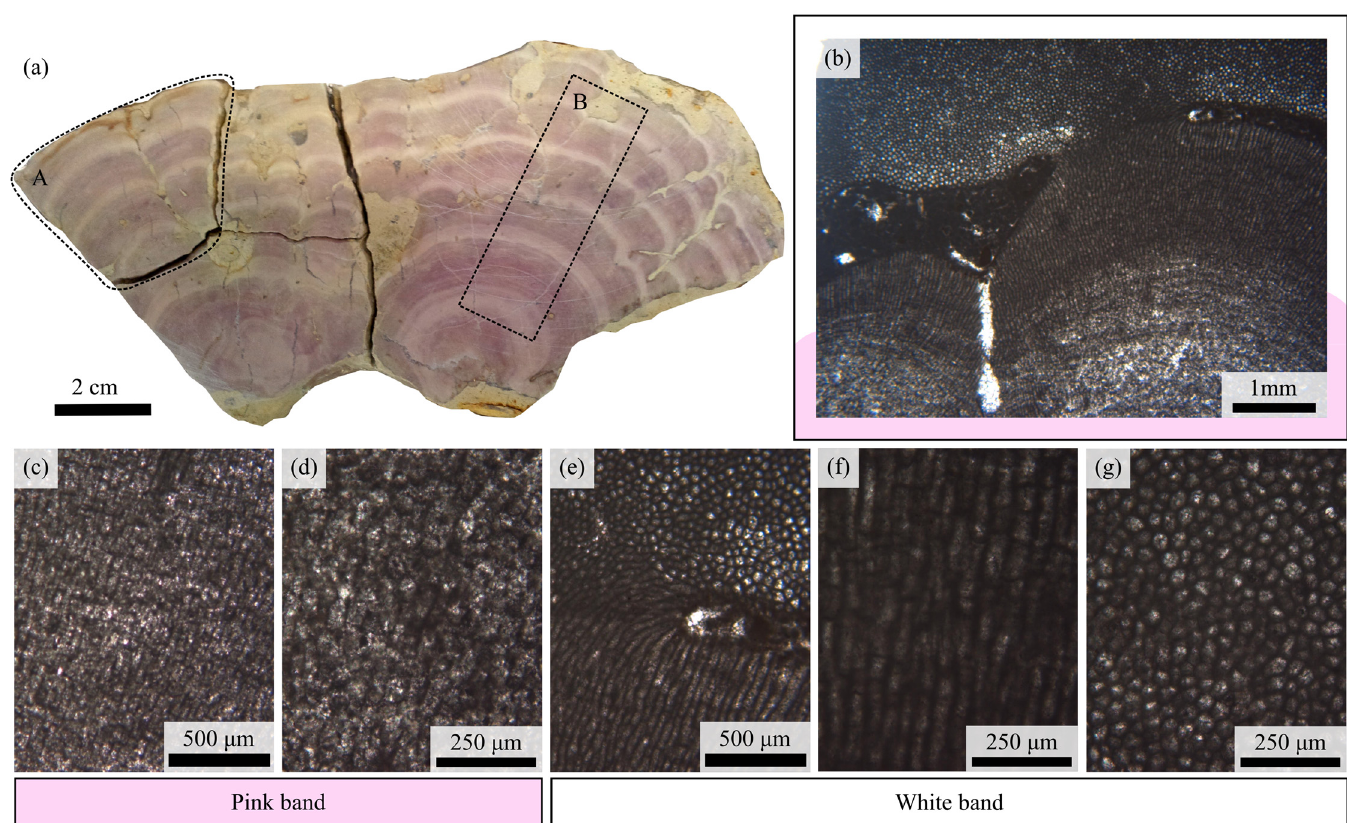
Fig 1. Photographs of Solenopora jurassica (UOM-232) used in the study. (a) Thick section of UOM-232. A, denotes the section subsequently analysed by 2D X-ray radiography, and B, the area mapped by XRF. (b-g) Light microscopy images of a thin section of UOM-232 showing the pink (b-c) and white (e-f) bands at different magnifications. The difference in cellular preservation between the two bands can be clearly seen under the light microscope, with the cellular structure clearly discernible in the white bands but not the pink ones.